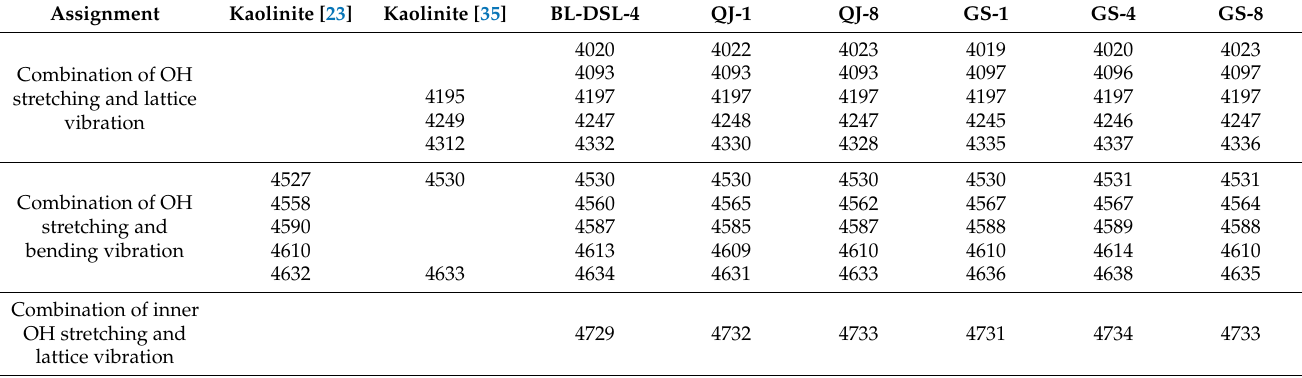
Table 3. The bands in the range of 4000–8000 cm − 1 for related samples and their assignments (cm − 1